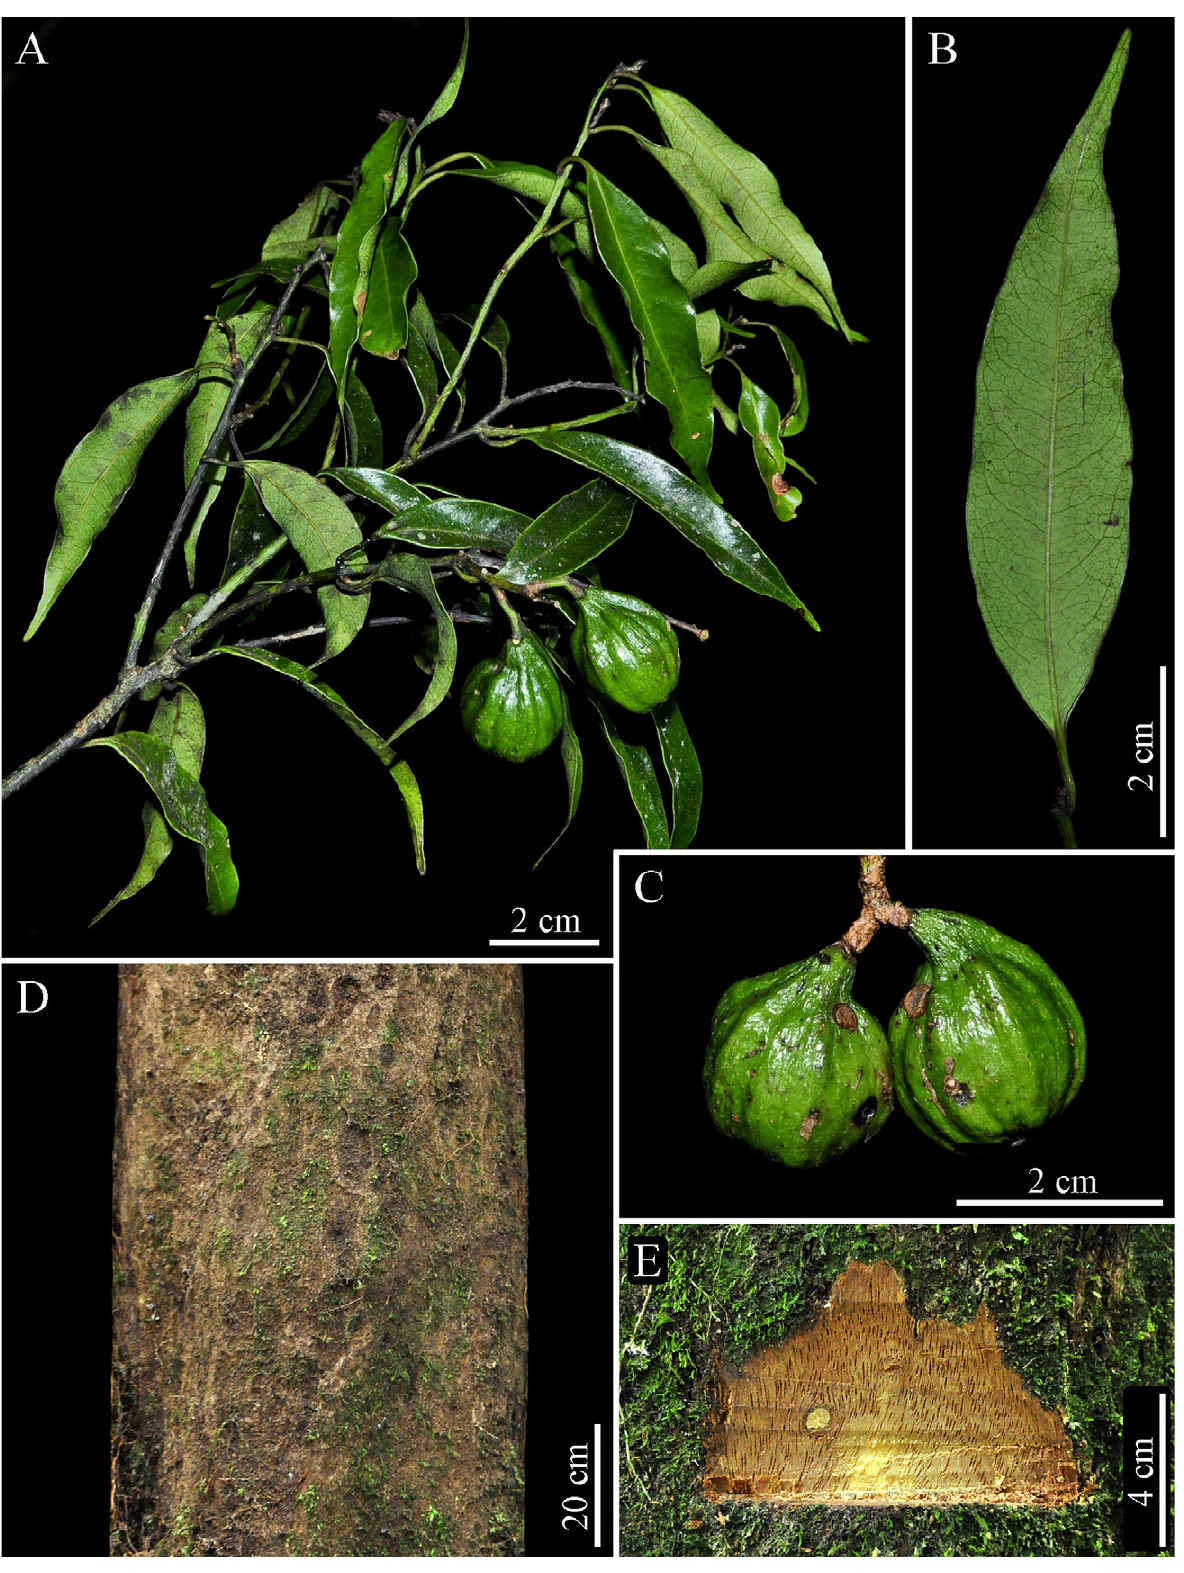
Figure 1. Cryptocarya botelhensis P.L.R.Moraes. A. Branch with immature fruits. B. Abaxial leaf surface. C. Immature fruits in the final stage of development. D. Bark appearance. E. Slash